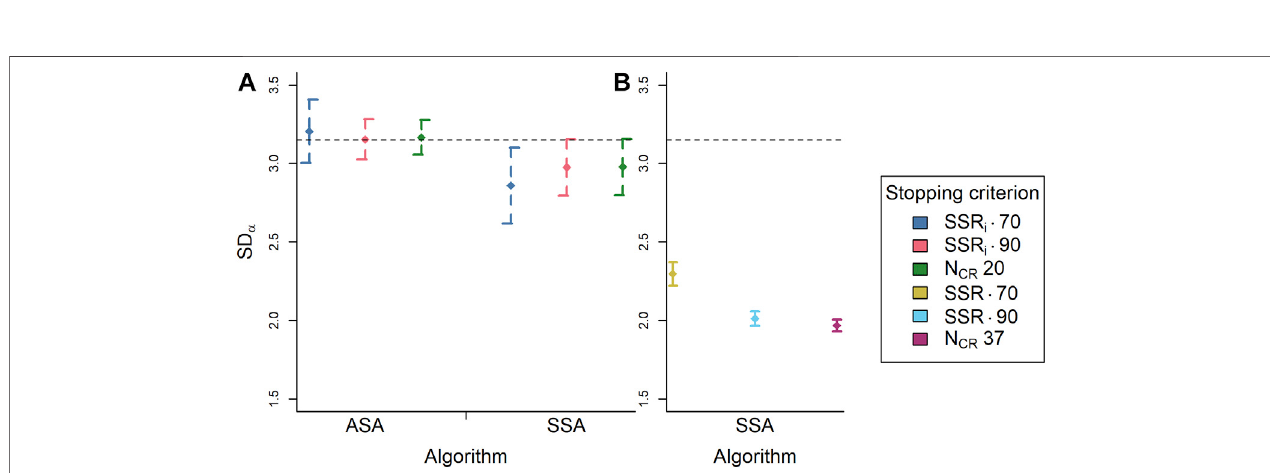
FIGURE 7 | The standard deviation of the ability estimates ( n = 20) averaged over simulation repetitions ( n = 1,000) per algorithm (ASA, SSA) and per stopping criterion [colors; (A) SSR i 0.70, SSR i 0.90, N CR 20; (B) SSR 0.70, SSR 0.90, N CR 37] with 95% con fi dence intervals ( n = 1,000) and the standard deviation of the generating ability values of the selected representations ( n = 20). Note: Panel (B) contains only SSA data. ASA = adaptive selection algorithm; SSA =